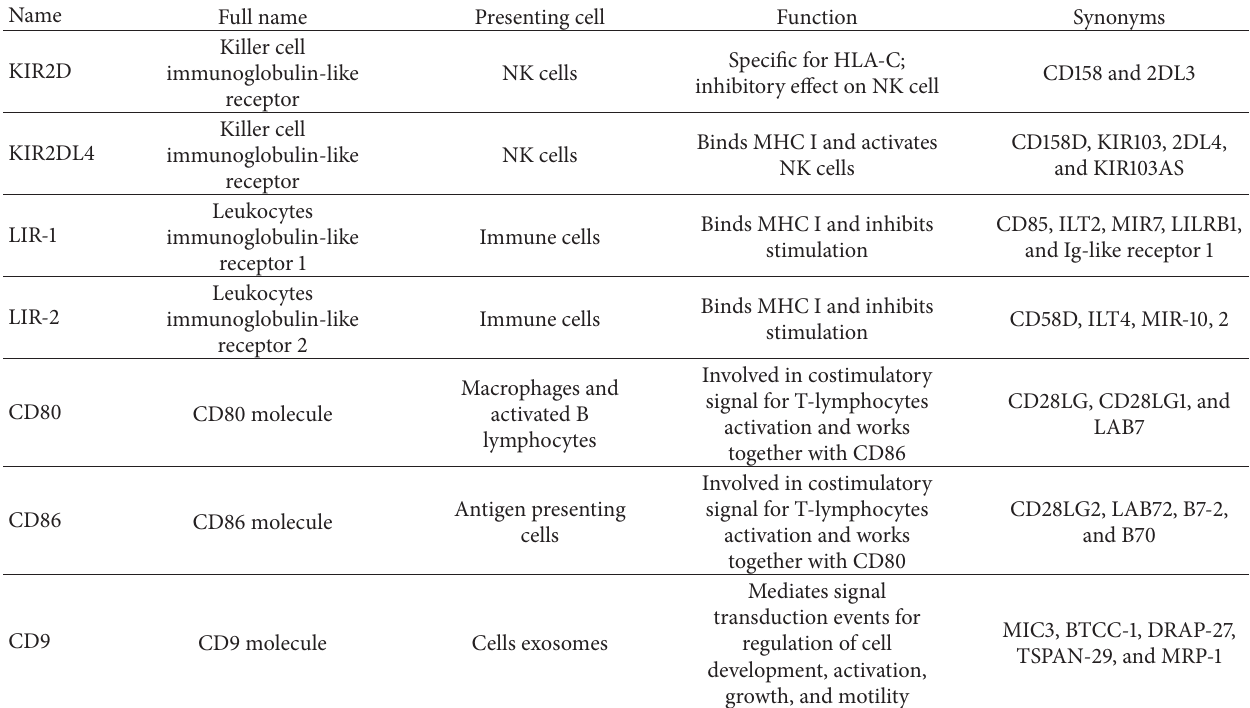
Table 3: Definitions of receptors and molecules mentioned in the